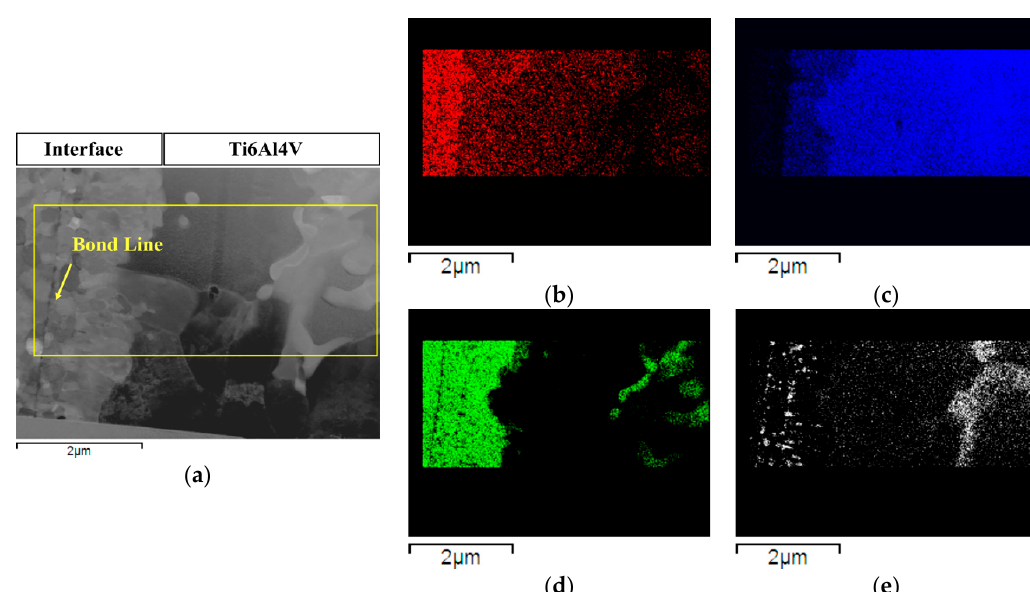
Figure 5. ( a ) STEM image of the TiNi/Ti6Al4V interface close to the Ti6Al4V alloy and EDS elemental maps of ( b ) Al, ( c ) Ti, ( d ) Ni and ( e ) V.